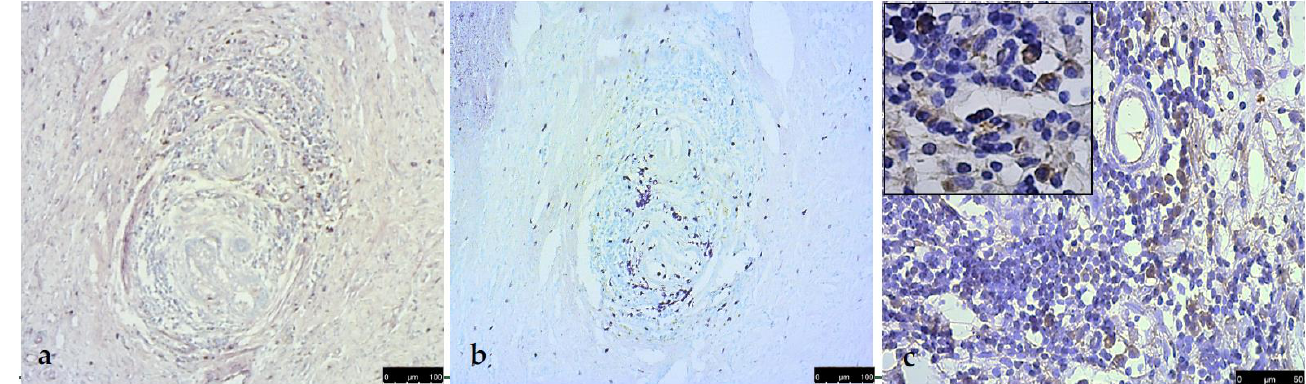
Figure 4. Immunohistochemistry of follicle-like structures: mast cells (( a ), MC tryptase, Vector Vip, 10 × ); macrophages (( b ), MAC/387, Vector Vip, 10 × ). Follicular dendritic cells (FDCs) variously located in both the outer and inner parts of the structure (( c ), CD21, DAB, 20 × ; inset, 40 × ). T lymphocytes sought by CD3 were located predominantly, but not exclusively, in